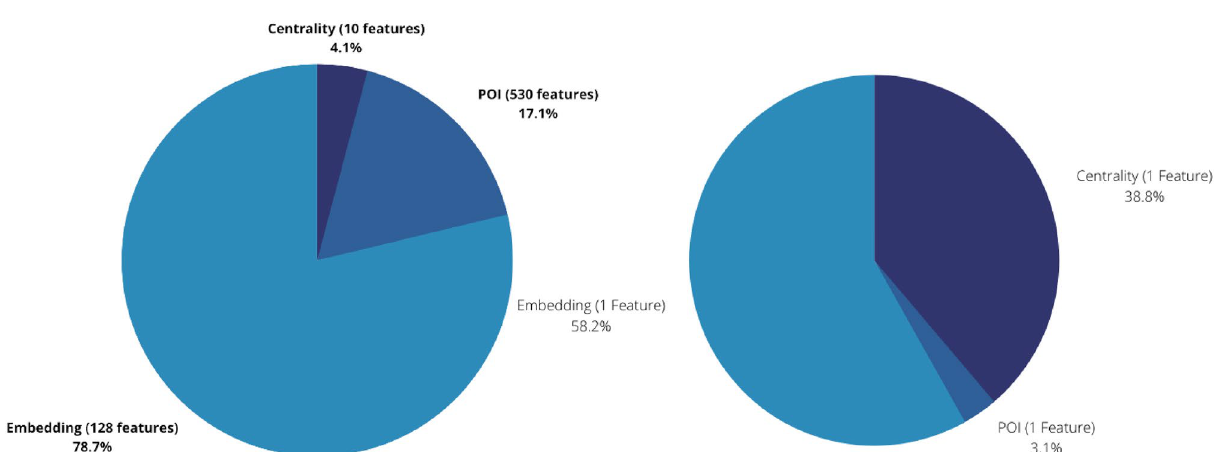
Figure 6. Total contribution to feature importance among 668 features is divided into three categories: (1) centrality, (2) POI, (3) road embedding. Left: road embedding, while contributing to only 19% of the total features, accounts for 78.7% of the total feature importance, while centrality features contribute to 4.1% and POI features to 17.1% of the total feature importance. Right: when normalized to individual feature importance, we can observe, the highest contribution is by embedding features where each feature contributes to 58.2% of the total embedding contribution of 78.7% where each centrality feature contributes to 38.8% of the total centrality feature importance of 4.1 while each POI feature contributes to only 3.1% of the total contributing feature importance of 17.1%. (Pie chart generated through matplotlib 45 Version 3.4.3 from